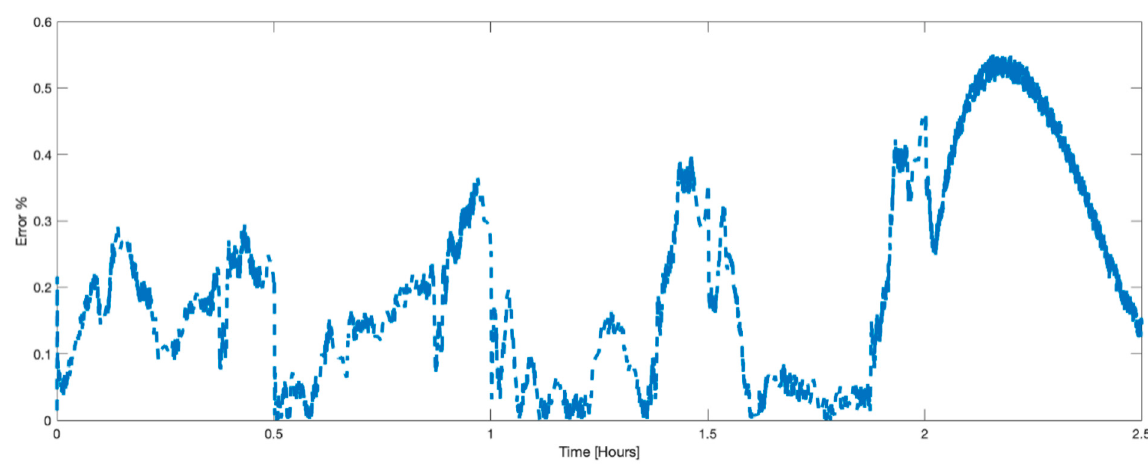
Figure 11. Cell II: Error rate versus time.